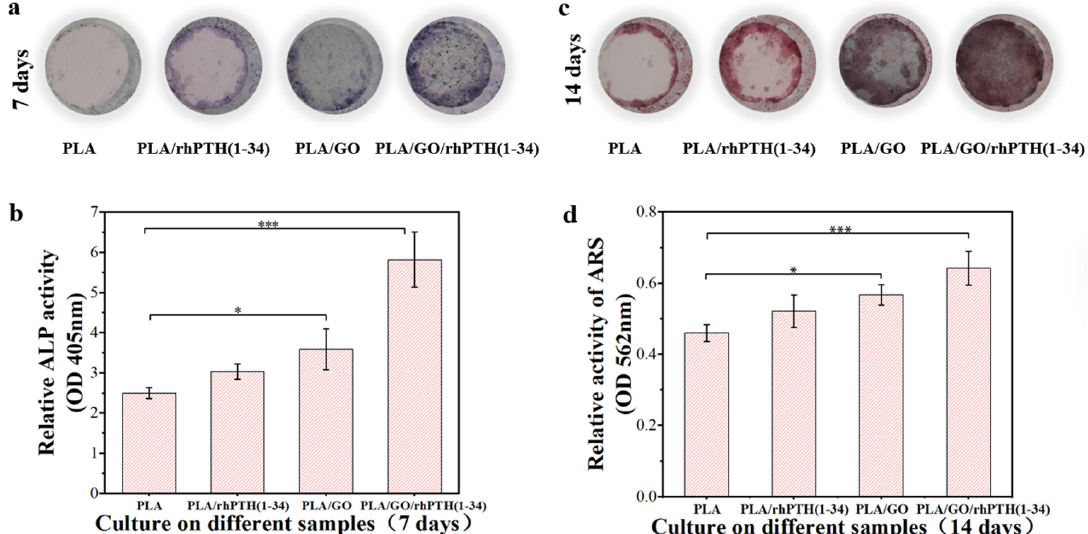
Figure 8. ALP activity and calcium deposition. ( a ) After 7 days of culture, MC3T3-E1 cells on the membranes were stained with ALP; ( b ) ALP activity was assayed using a quantitative colorimetric assay (Notes: * p < 0.05, *** p < 0.001); ( c ) after 14 days of culture, MC3T3-E1 cells on the different membranes were stained with ARS; ( d ) calcium deposition activity was assayed using a quantitative colorimetric assay (Notes: * p < 0.05, *** p < 0.001).